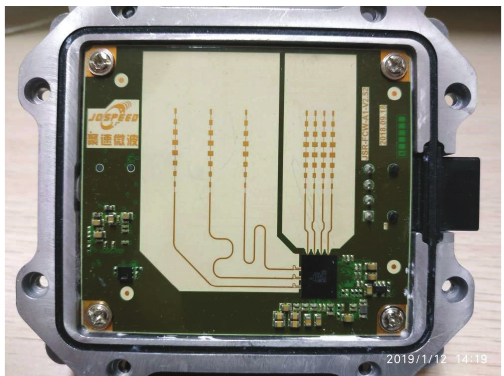
Figure 4. Multi-target FSK (Frequency-Shift Keying,